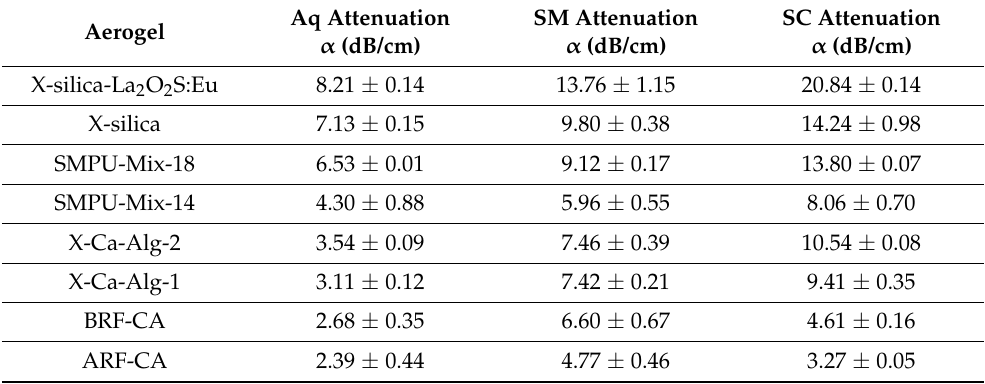
Table 6. Measurement of α for three different environments; Aq, SC and SM at a scan frequency of 8.5